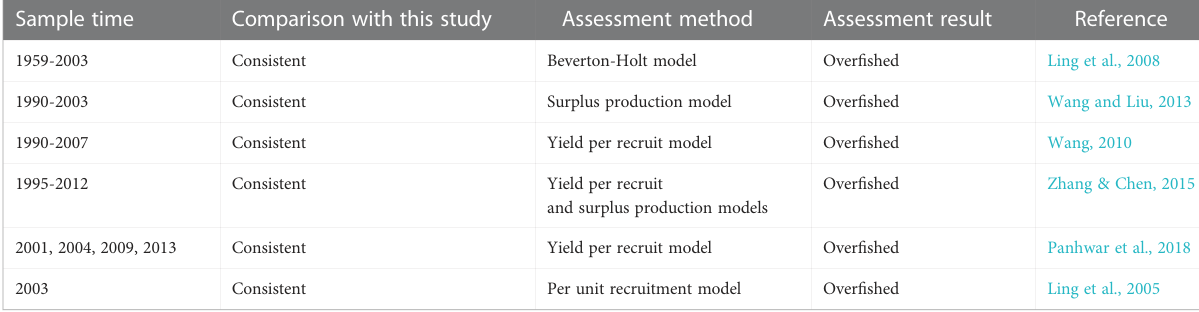
TABLE 4 Comparison of fi shery resource assessment studies for T. lepturus in the East China Sea. Sample time